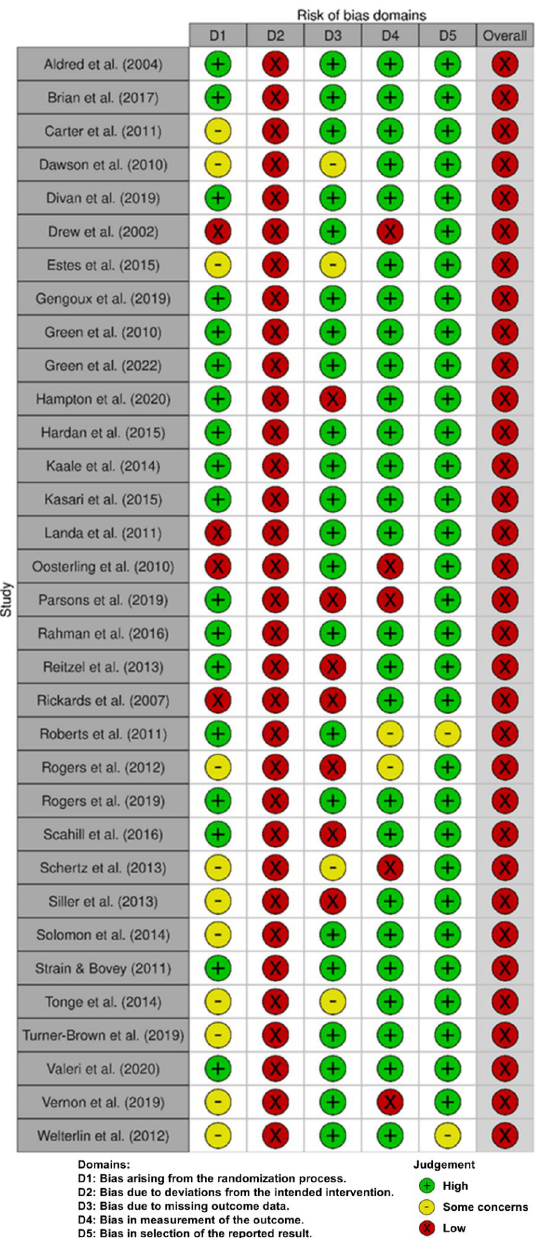
Figure 2. Risk of bias assessment [27–59].